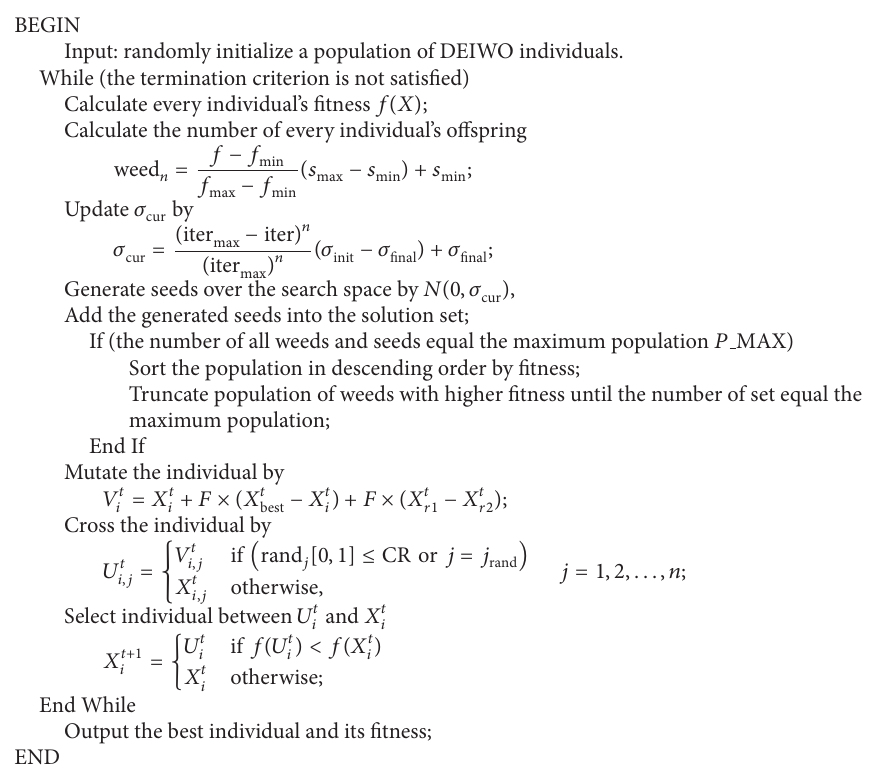
Pseudocode 1: The pseudocode for DEIWO